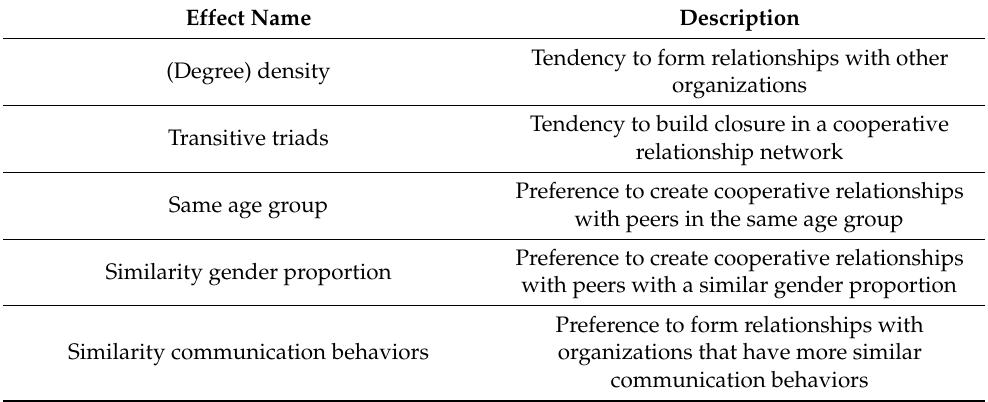
Table 2. Description of the effect included in the